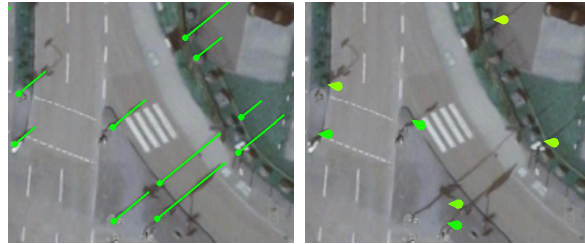
Figure 12. Section 57 × 48 m 2 from fig. 8, left: detected poles and footpoints, right: radar GCPs